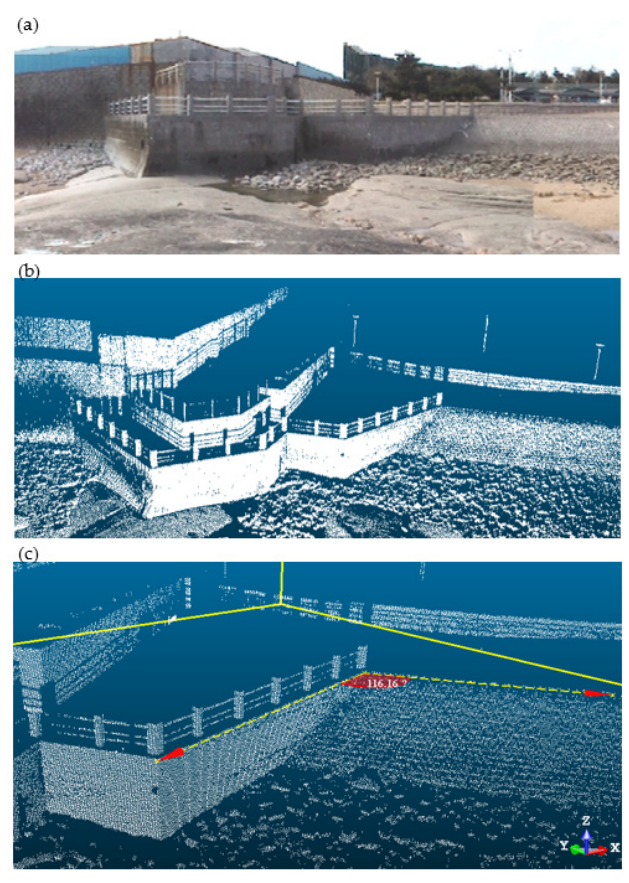
Figure 2. Point 11 on the Weifang levee: ( a ) photograph, ( b ) 3D point cloud data, and ( c ) measurement of levee angle using 3D point cloud data. of levee angle using 3D point cloud